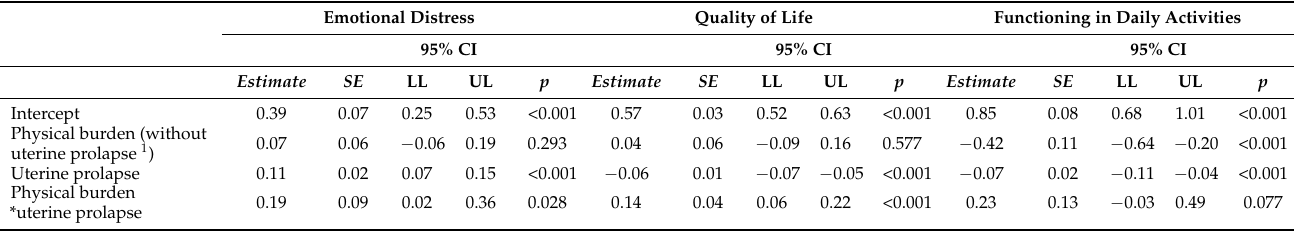
Table 4. Generalized estimating equations of objective physical burden of carrying water and psychosocial well-being and its moderation by uterine